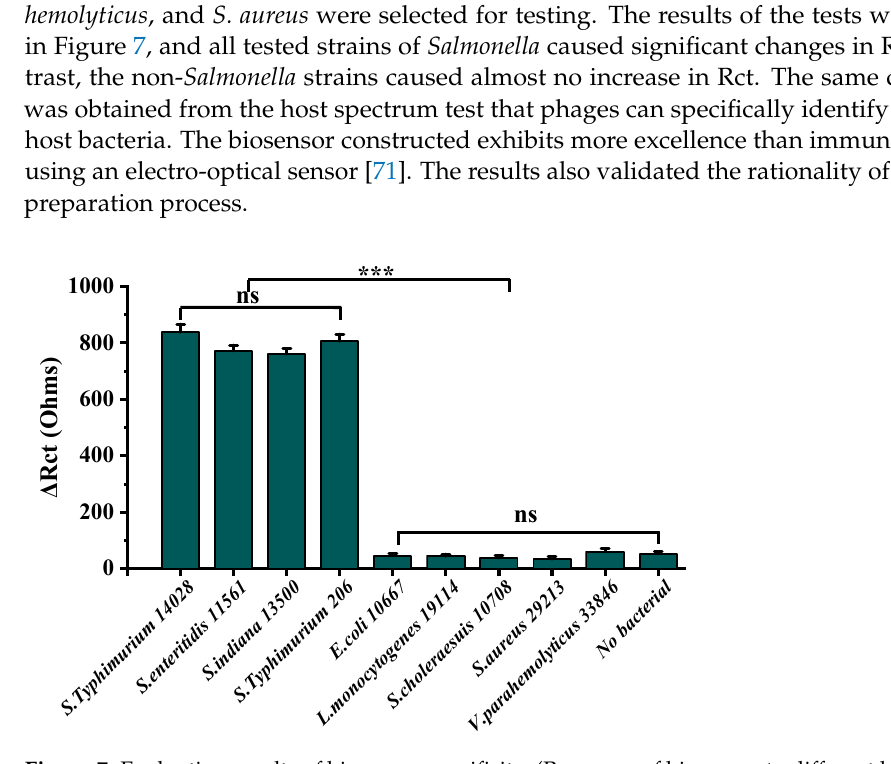
Figure 7. Evaluation results of biosensor specificity. (Response of biosensor to different host bacteria, ***: p < 0.001, ns: no significance difference).